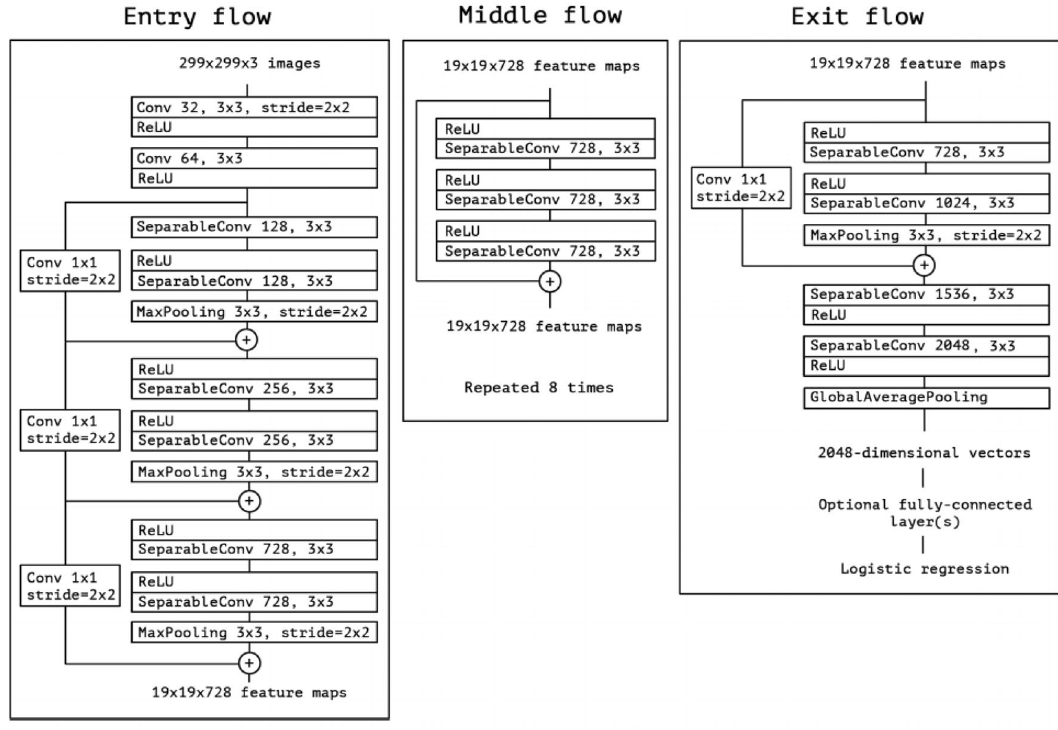
Figure 3. A figure representing the Xception architecture 26